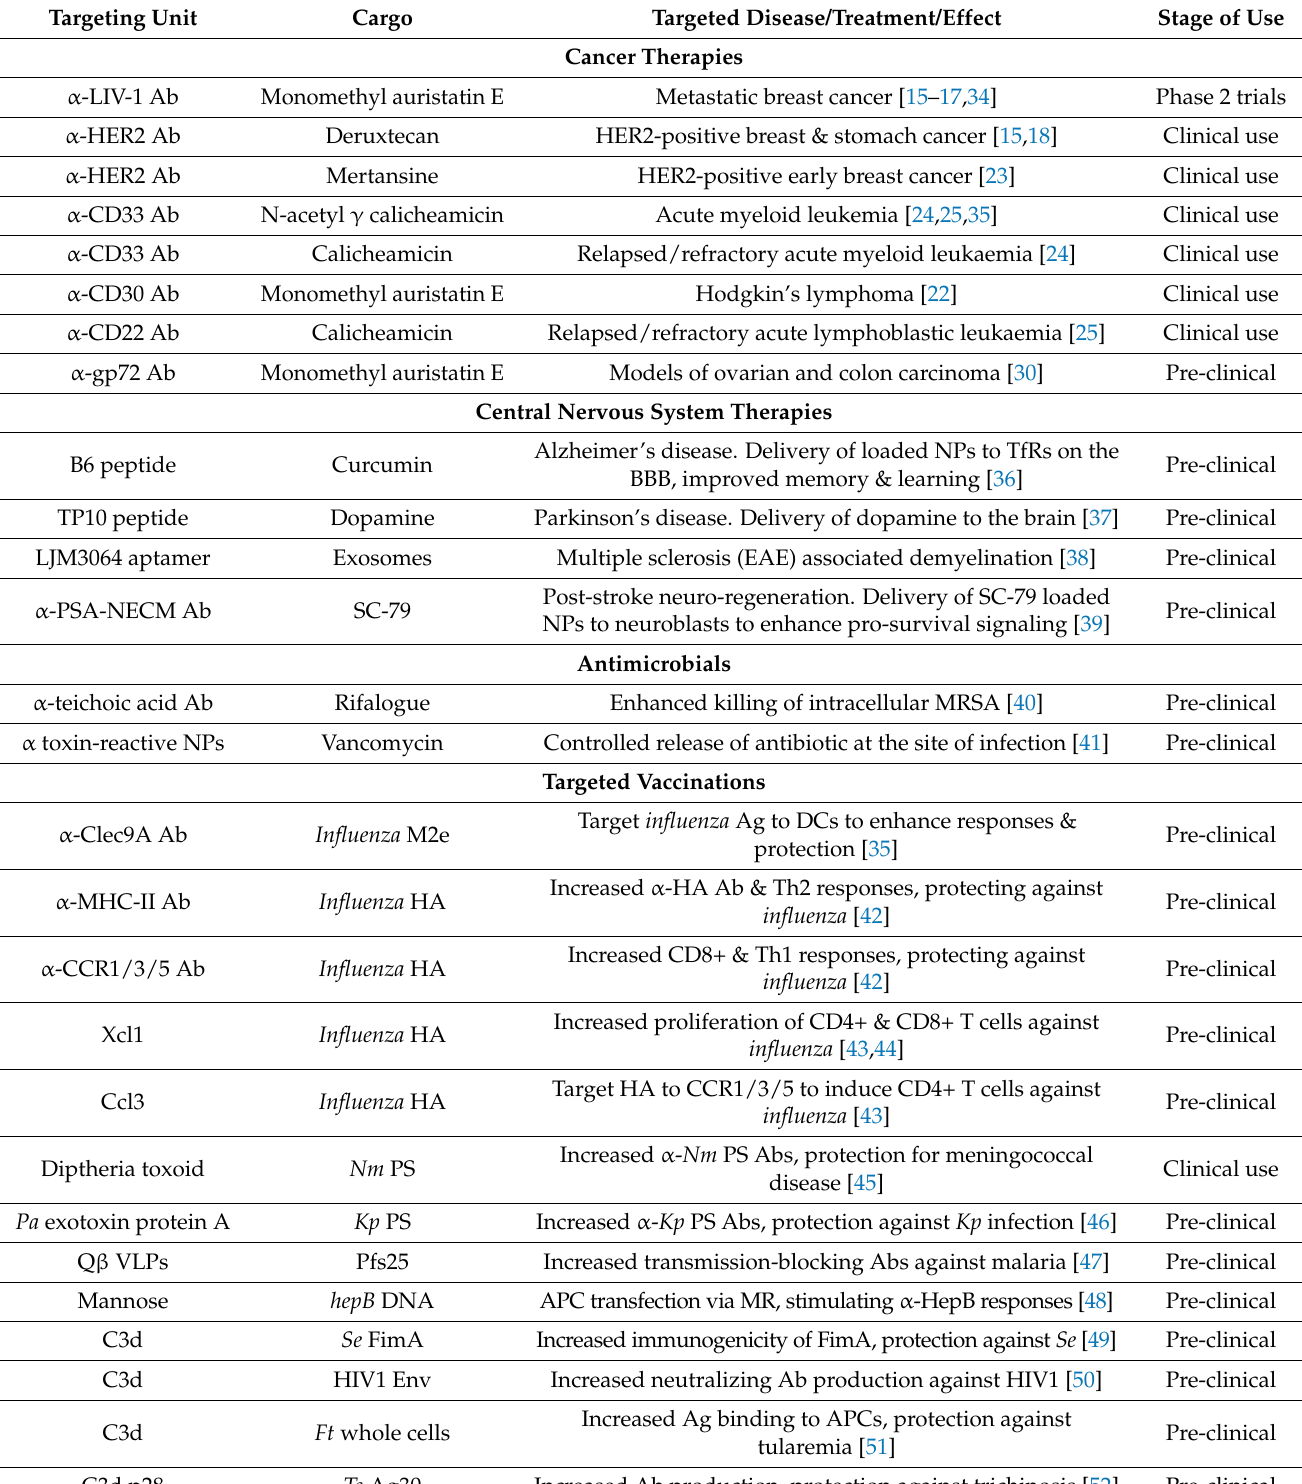
Table 1. Examples of targeted therapies and